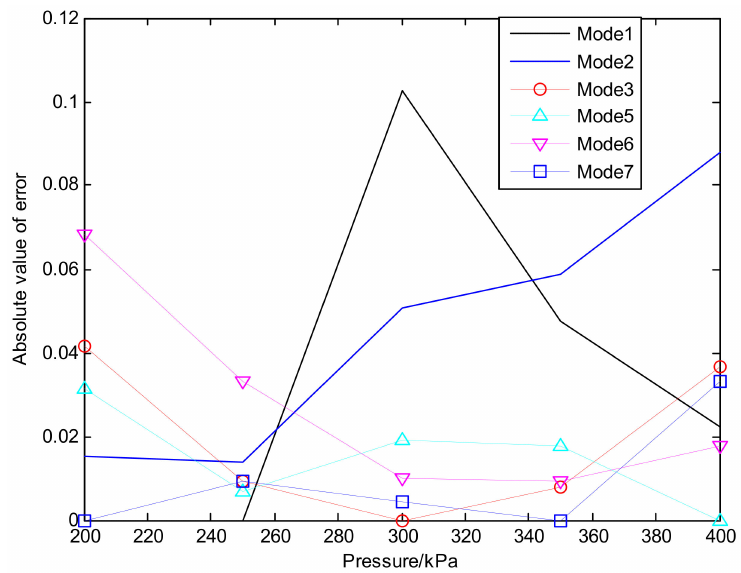
Figure 9. Absolute error between the actual flow rate and the theoretical flow